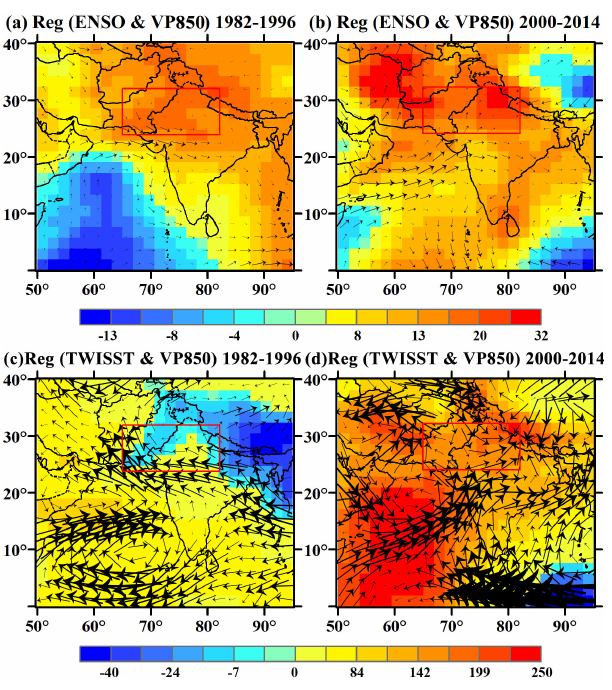
Figure 14. (a–b) Regression of ENSO with TWISST-related sig- nals removed onto velocity potential at 850hPa (VP850) and wind in the dust season (June–July). (c–d) Regression of TWISST with ENSO-related signals removed onto velocity potential at 850hPa (VP850) and wind in the dust season (June–July).